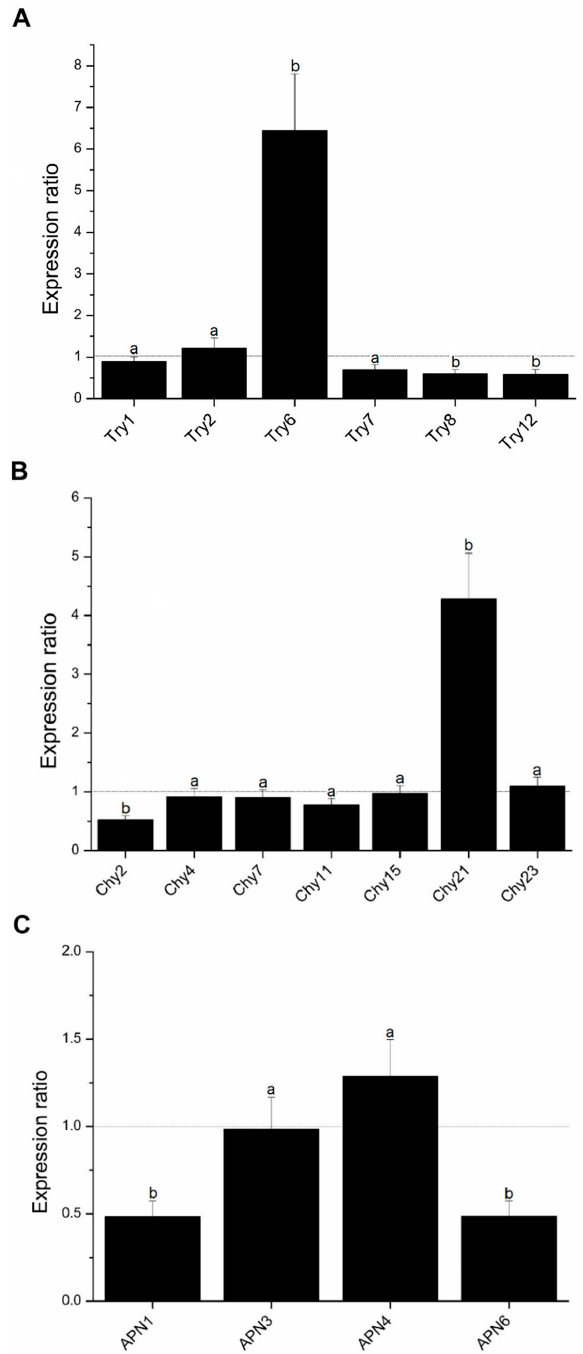
Figure 7. Relative expression of trypsin ( A ), chymotrypsin ( B ) and N -aminopeptidase ( C ) genes of fifth instar of talisin-fed Spodoptera frugiperda larvae. Genes above the dotted line were considered more expressed and genes below the dotted line were considered less expressed. Different letters indicate significant differences ( p < 0.05).